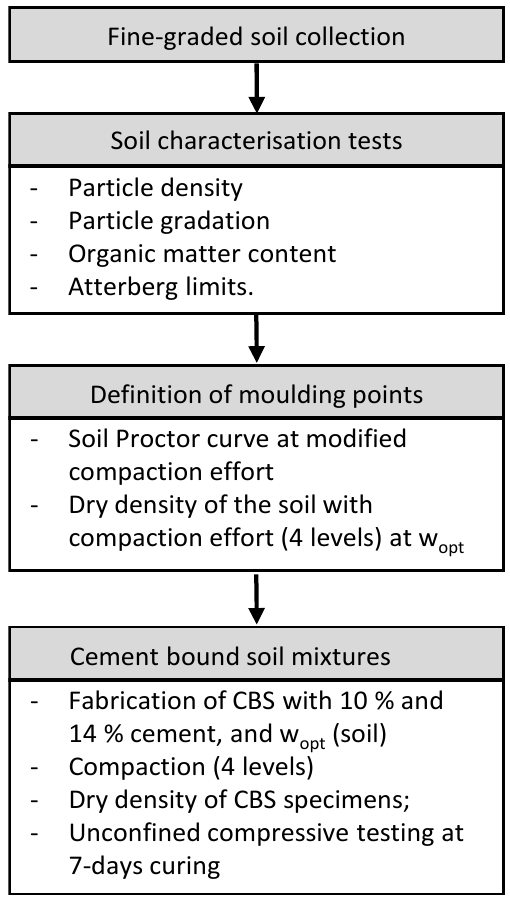
Figure 1. Diagram of the experimental plan.